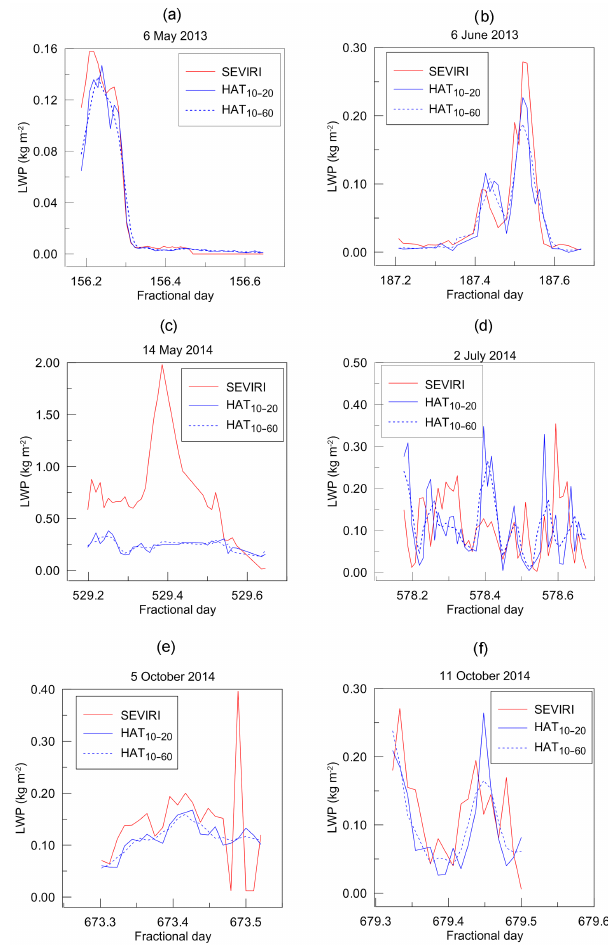
Figure 6. The examples of instantaneous measurements of LWP by SEVIRI and by HATPRO (two HATPRO data sets used were HAT 10 − 20 and HAT 10 − 60 ). Several days of the WH season are shown (1 day is one